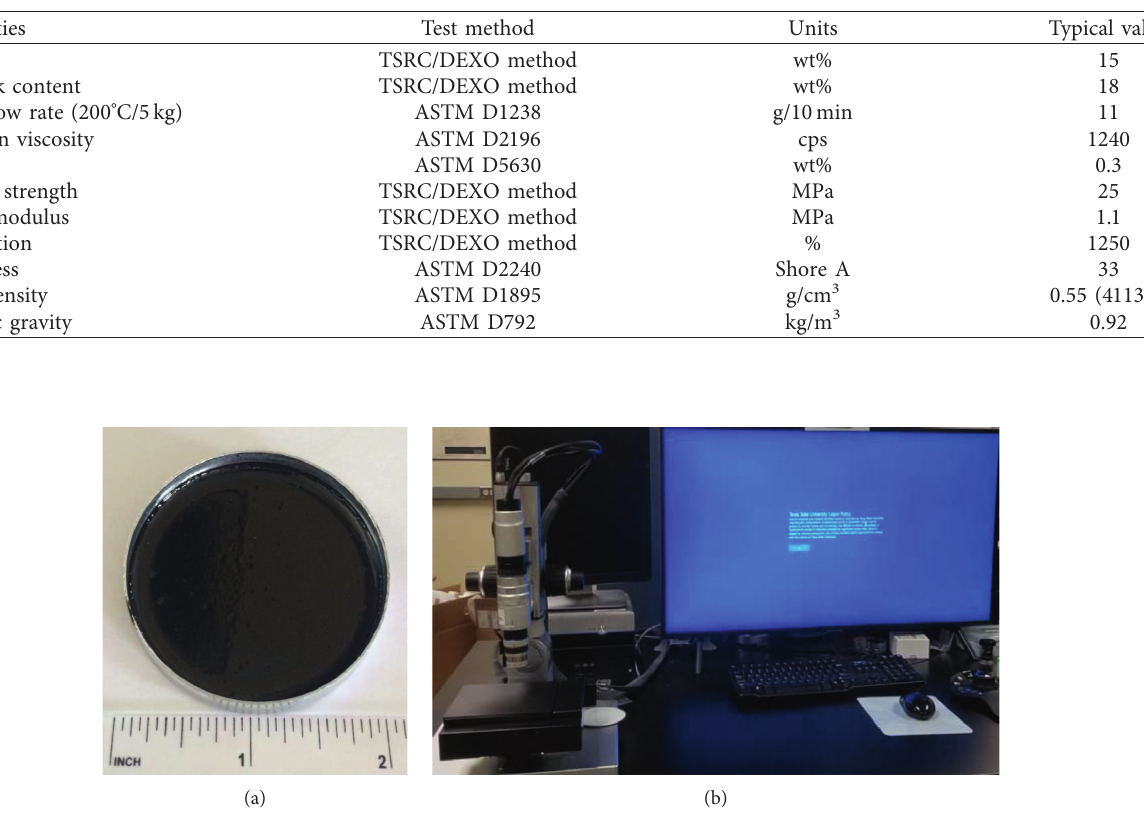
Figure 3: (a) Asphalt sample for morphology investigation and (b) Hirox digital microscope.